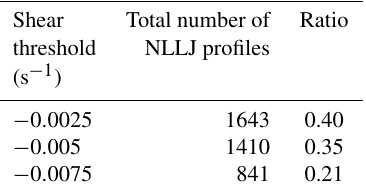
Table 3. Number of profiles flagged as NLLJ and the ratio of NLLJ profiles to all valid nocturnal profiles for different thresholds of the vertical shear in the horizontal wind speed.